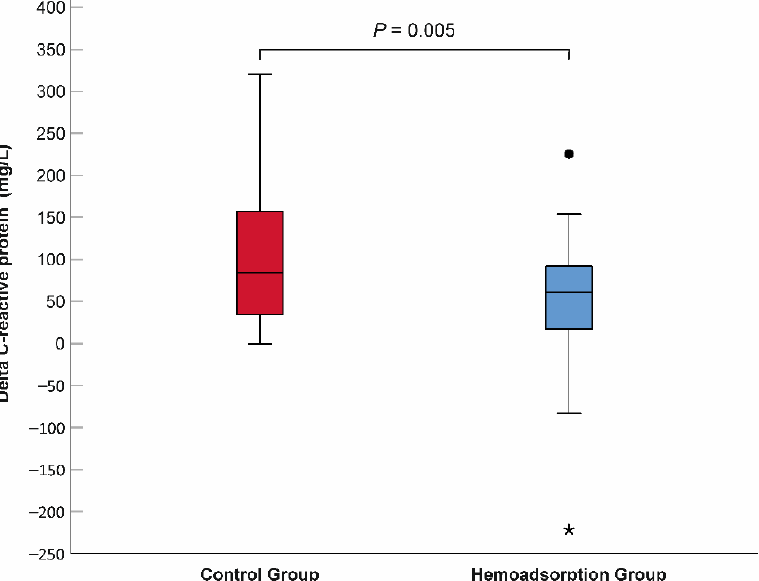
Figure 4. Comparison of delta C-reactive protein between the hemoadsorption and control groups. N = 58. Delta C-reactive protein = 72-h CRP–baseline CRP. Filled circle indicates outlier, while asterisk represents extreme value.